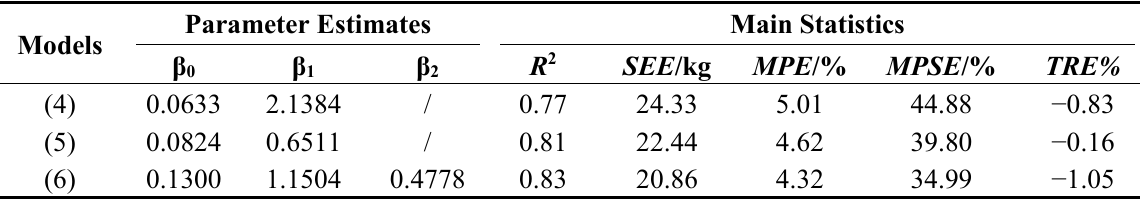
Table 3. The fitting results of fixed-effects models of crown biomass.